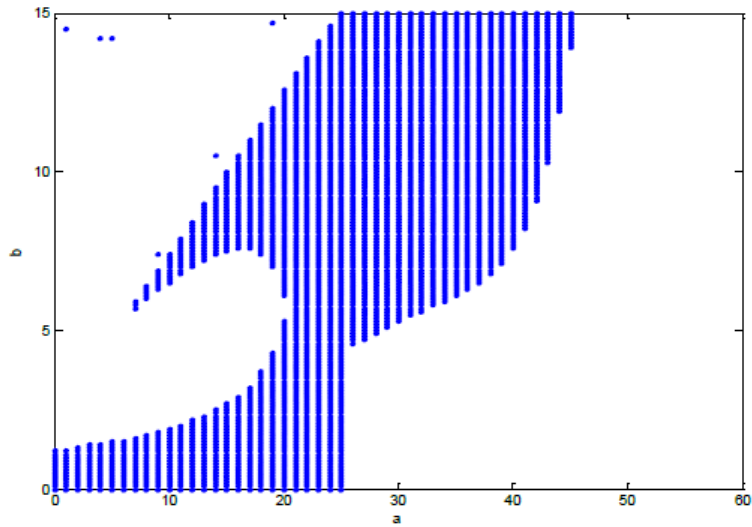
Figure 11. Regions stability for m = 10 and δ =